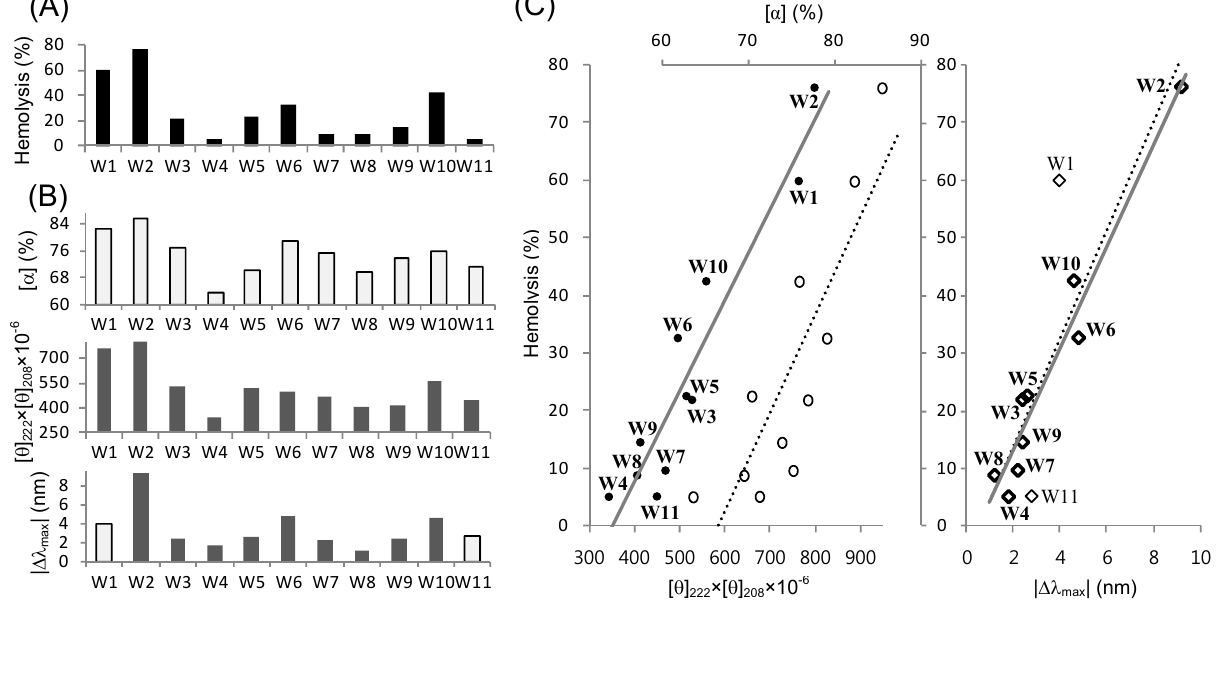
Figure 6. Relationships between hemolytic activity and structural parameters of the L K W n model peptides. ( A ) Hemolysis extents (%) by individual peptides at a 128 μ g/mL 5 5 concentration were extracted from Figure 2; ( B ) Structural and spectroscopic parameters of individual peptides in 50% (for CD) or 75% (for fluorescence) TFE solutions. Predicted helical contents ([ α ]; upper panel) and the [  ] derived from the CD data in Figure 3. Differences in  peptides and NATA were derived from fluorescence emission data in Figure 5. Light gray bars correspond to the light symbols in C ; ( C ) Linear correlation between hemolytic activity and structural parameters in 50% (for CD) or 75% (for fluorescence) TFE solutions. The hemolysis % is plotted along the [  ] coordinate; left panel) and [ α ] (empty circles with upper coordinate; middle panel), respectively, with the corresponding regression lines determined by linear least square fitting. The coefficients of determination R 2 were 0.9022 (solid line) and 0.7321 (dotted line), respectively. The hemolysis % is also plotted along the |  panel). The linear regression lines were derived using all 11 data points (dotted line; R 2 = 0.7776) and 9 selected data points (solid line with bold diamond symbols; R 2 = 0.9518),